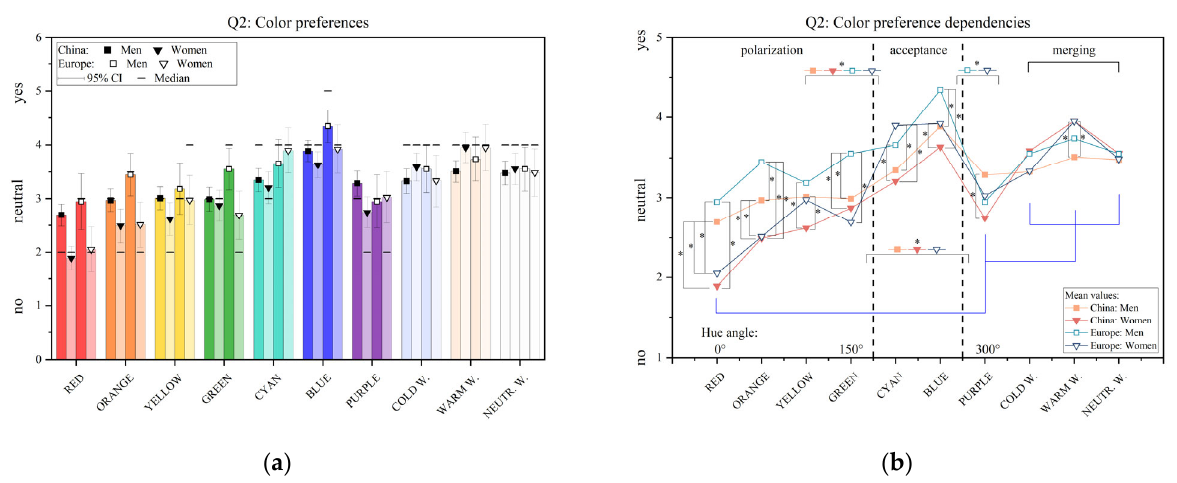
Figure 2. ( a ) Color preferences rating and ( b ) statistical evaluation separated between the Chinese ‐ and Europe ‐ group and genders. Statistical significances p < 0.05 marked with *.